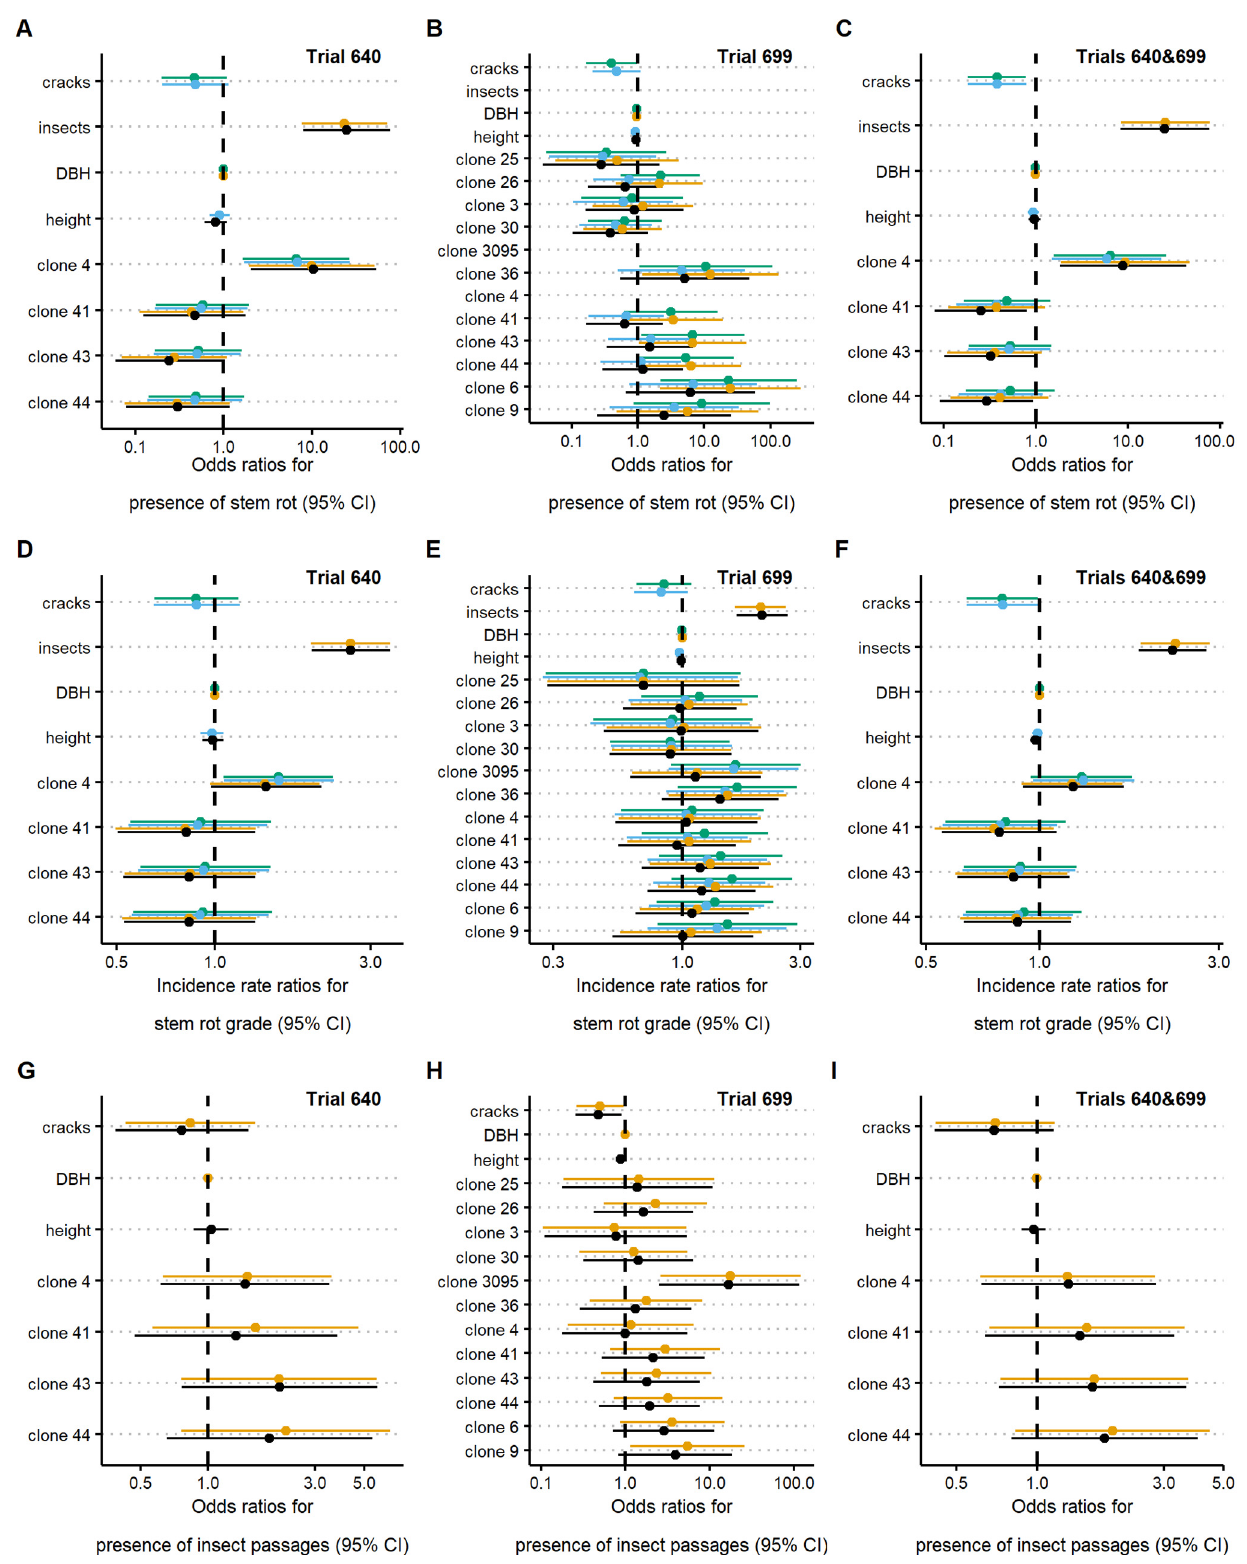
Figure 1. Forest plots of the multiple linear regressions (presented in different colors) with the presence of stem rot ( A – C ), stem rot grade ( D – F ), and presence of large polar borer passages ( G – I ) as dependent variables. Whiskers denote 95% confidence intervals (95% CI) of exponentiated coefficients. Non-overlap with the vertical intercept (dashed line) indicates statistically significant effect of an independent variable.